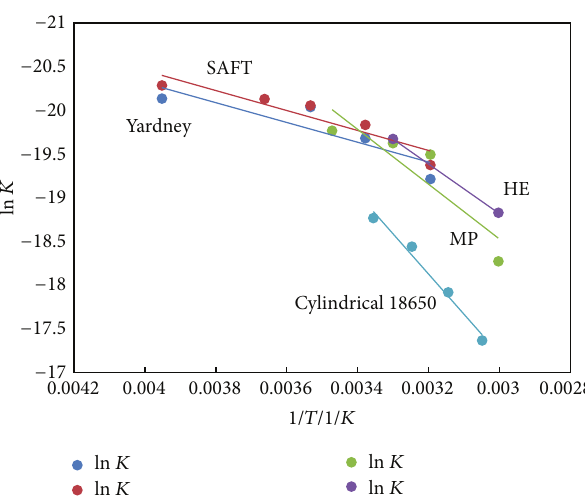
Figure 5: Percentage capacity loss versus time for 18650 lithium ion cell (Sandia) at 25 ∘ C, 35 ∘ C, 45 ∘ C, and 55 ∘ C.